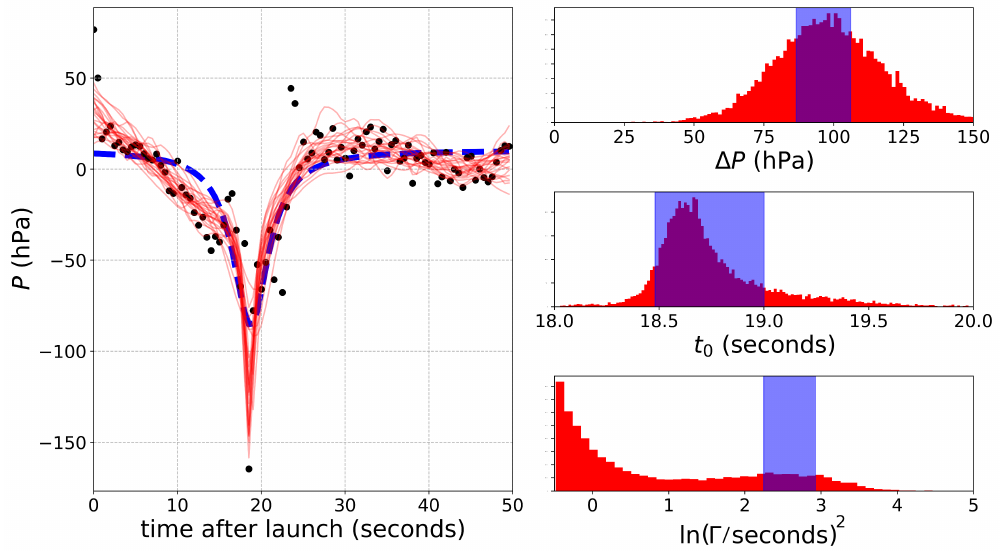
Figure 9. Model fits and parameters for the pressure residuals from Flight 1 (i.e., from Figure 8). The left panel shows two model fits to the dust devil 1 encounter—the best-fit model shown by the dashed, blue line assumes white noise and uses the Levenberg–Marquardt fitting routine but does not illustrate the noise at all (i.e., does not include any scatter in the line). The solid, red lines show fits assuming a Gaussian processes noise model and a Markov Chain Monte Carlo (MCMC) parameter space sampling and includes several estimates of the noise signal—hence the waviness. The right panels show the best-fit parameters—shaded blue, the 1- σ uncertainties for the former modeling scheme, and red, the distributions from the MCMC